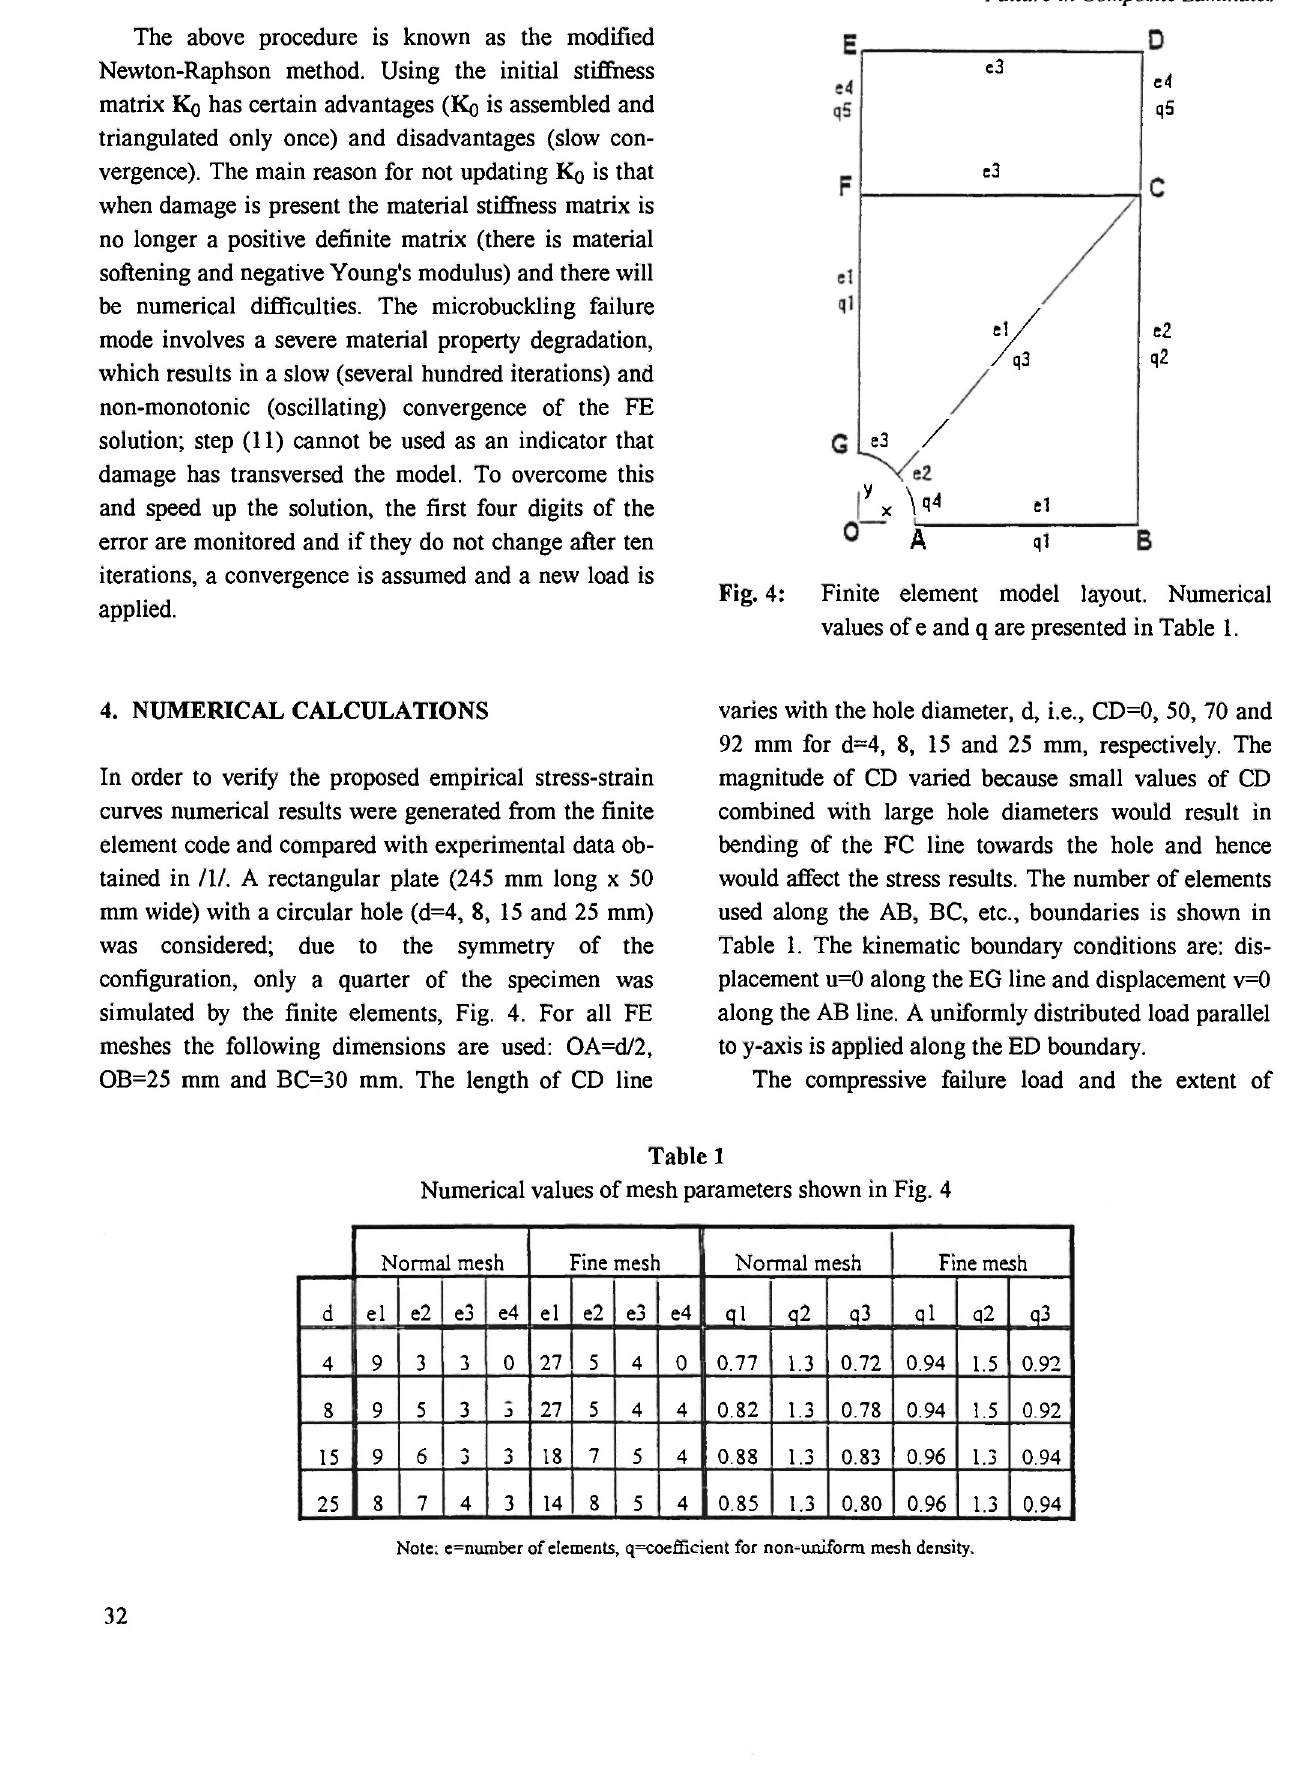
Fig. 4: Finite element model layout. Numerical values of e and q are presented in Table 1.